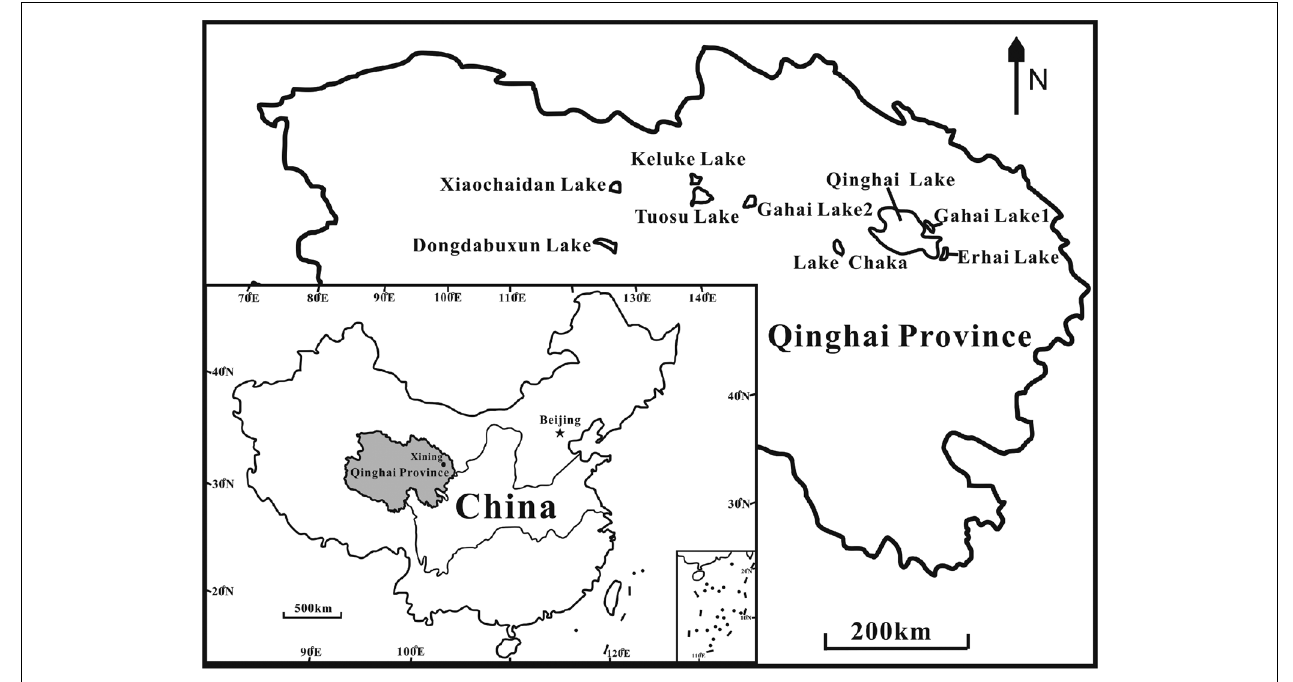
FIGURE 1 |A geographic map showing the locations of the studied lakes on the Qinghai–Tibet Plateau, China.